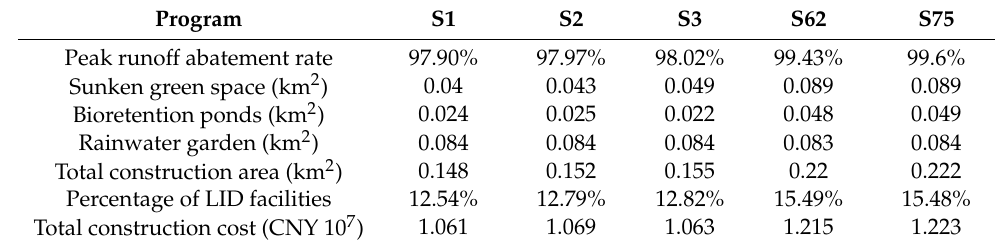
Table 3. Analysis of different optimization options based on peak runoff abatement